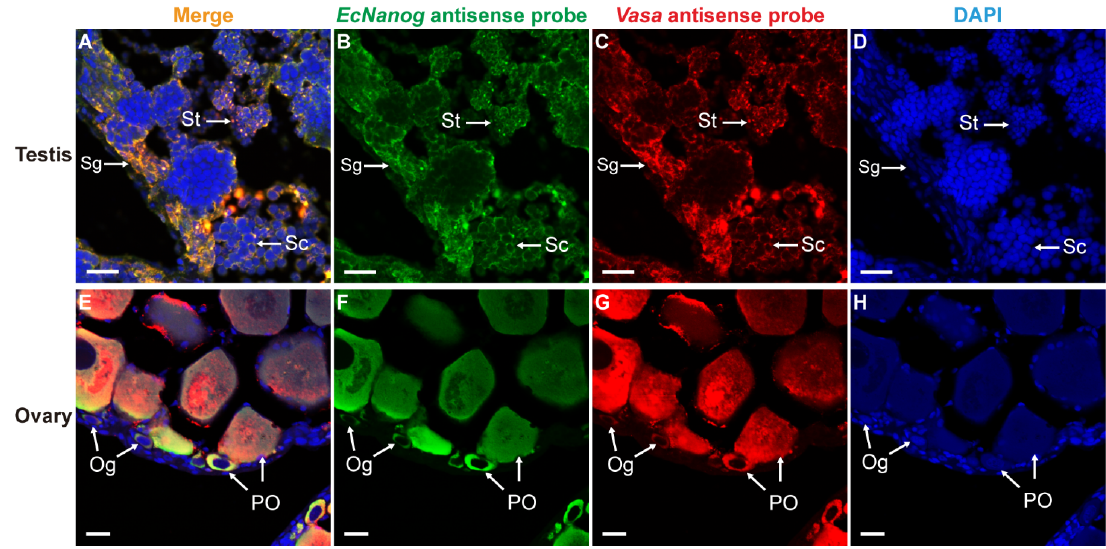
Figure 8. Co-localizations of EcNanog and Vasa in gonads of orange-spotted grouper. ( A , E ) Merged images. ( B , F ) Fluorescent signal of EcNanog antisense probe in testis and ovary. ( C , G ) Fluorescent signal of Vasa antisense probe in testis and ovary. ( D , H ) Nucleus was counterstained with DAPI. Sg, Spermatogonium; Sc, Spermatocyte; St, spermatid; Og, oogonium; PO, primary growth stage oocyte. Scale bars: 20 µ